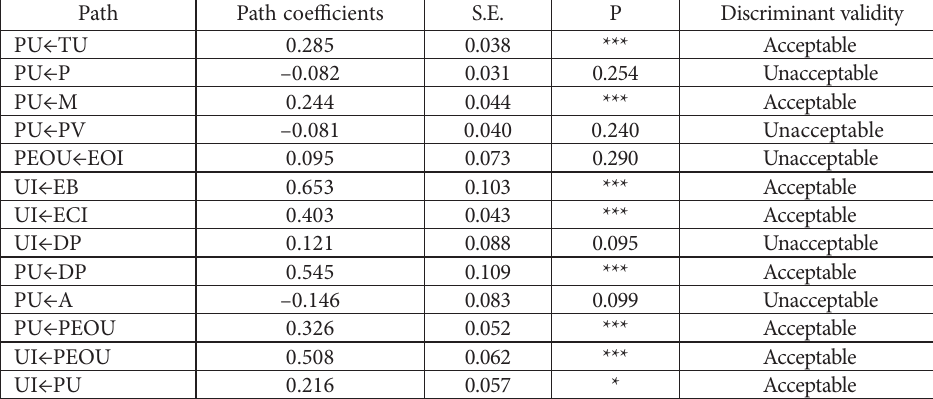
Table 5. Results of discriminant validity test